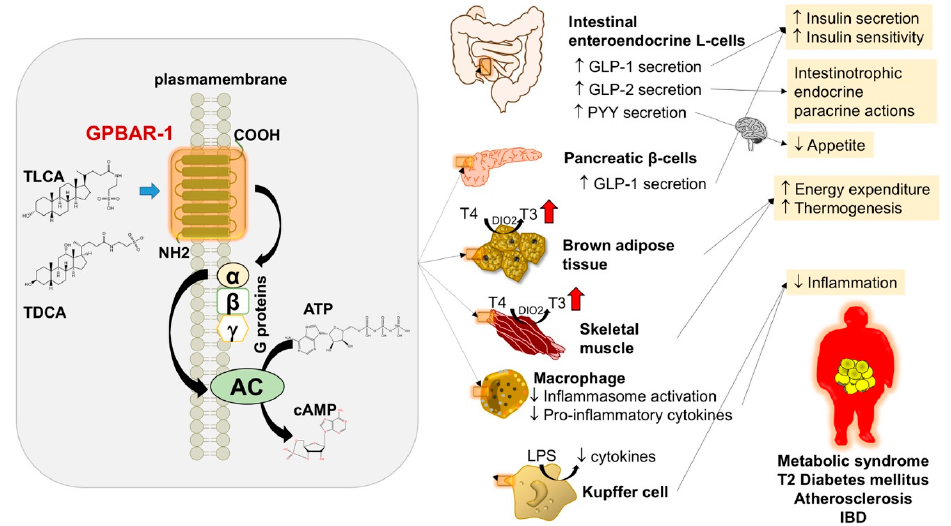
Figure 3. Effects of BA signalling through activation of the GPBAR-1 in target tissues [2,96]. The